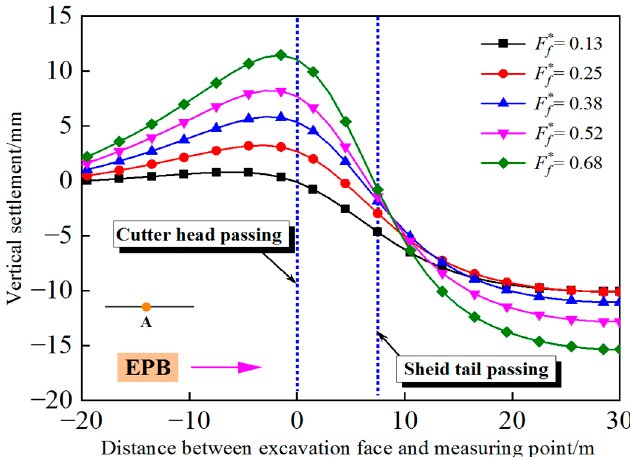
Figure 18. Vertical settlement at point A under different friction coefficients F ∗